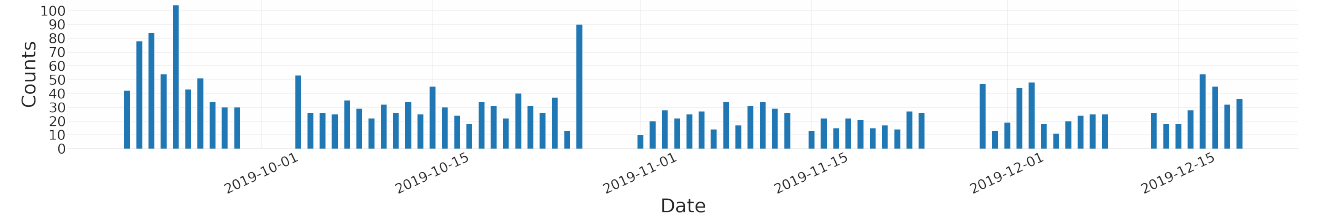
Figure A2. Number of interlocks happened per day from 18-9-2019 to